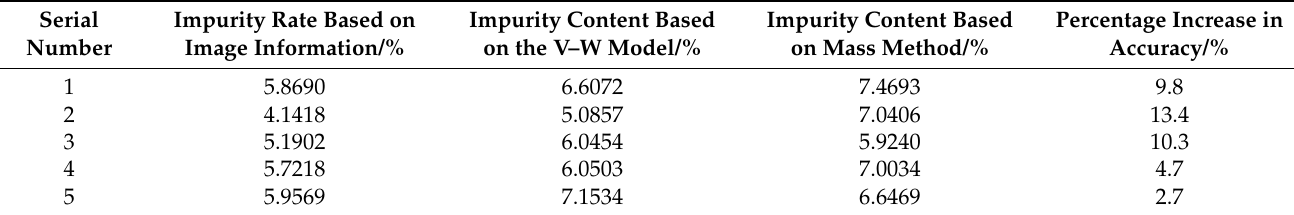
Table 5. Comparison of impurity contents of the three